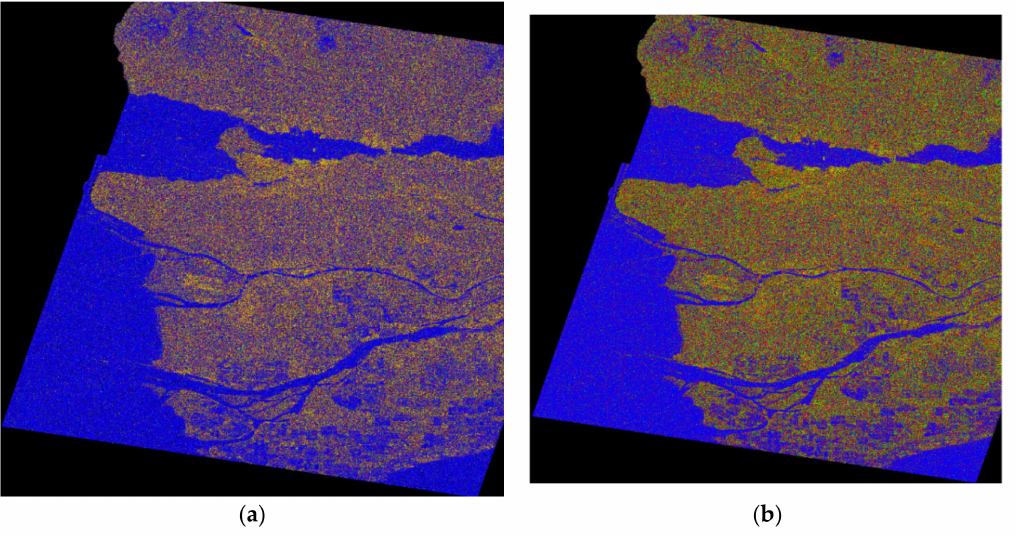
Figure 11. ( a ) Coloring based on the proposed double scatterer representation method. ( b ) Cameron’s CTD coloring